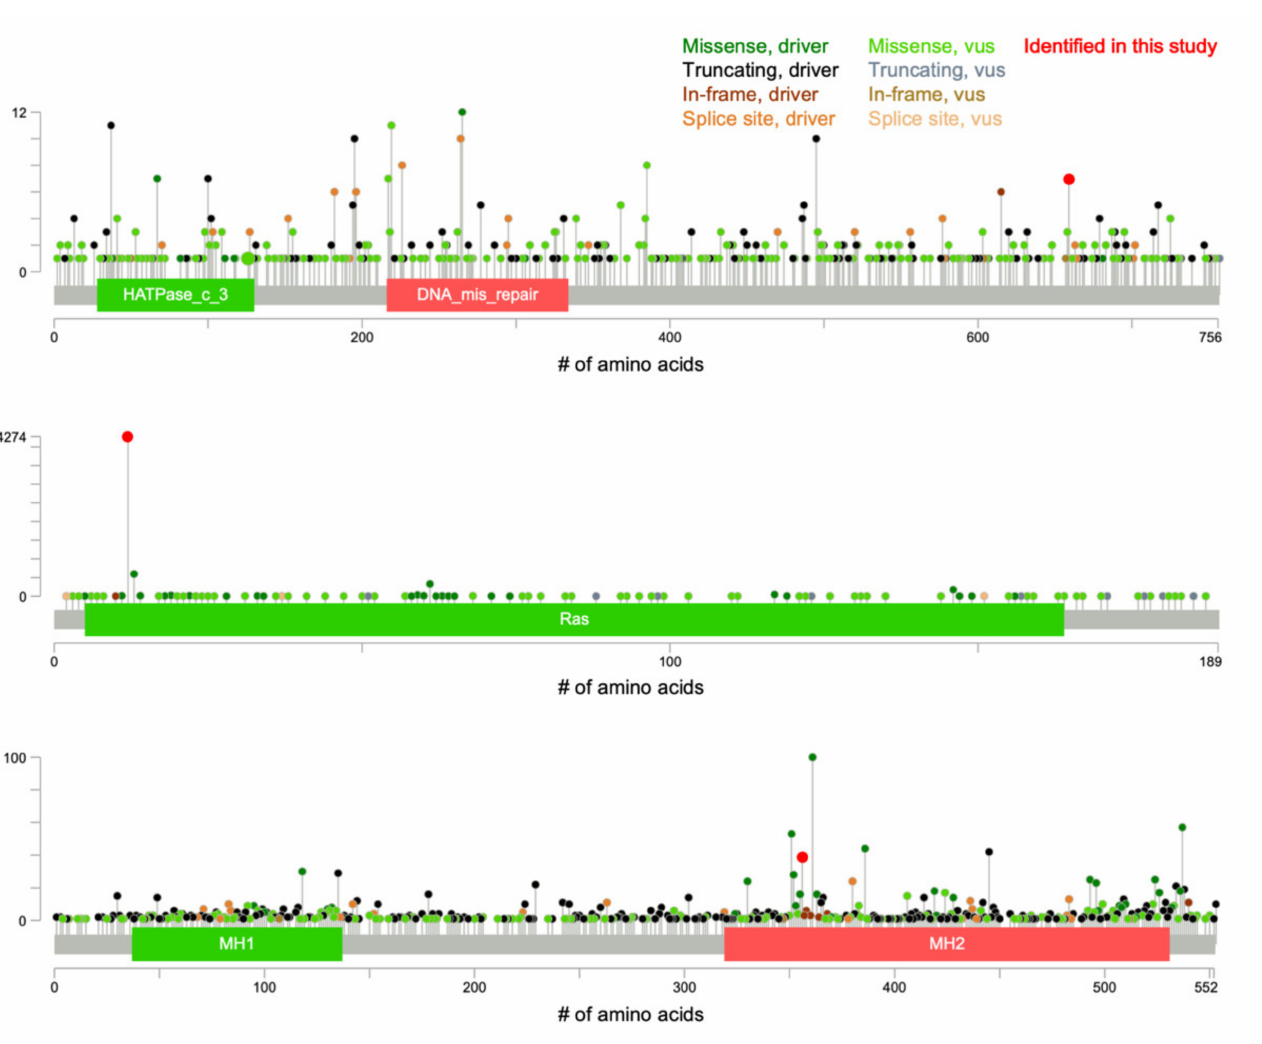
Figure 2. Somatic mutation spectra for ( A ) MLH1 , ( B ) KRAS , and ( C ) SMAD4 in 56,990 cancers of various origins. Figures were created on cBioPortal using the dataset, ‘curated set of non-redundant studies’, with modifications. vus, variant of unknown significance, #,